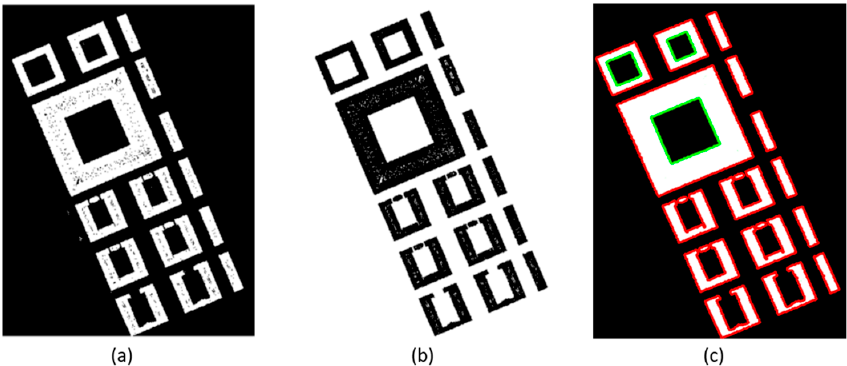
Figure 3. Building block boundaries. ( a ) Raster image of the point cloud P r ( I b ) . ( b ) Image I b , defined to remove noisy elements. ( c ) External and internal building boundaries, coloured in red and green, respectively.